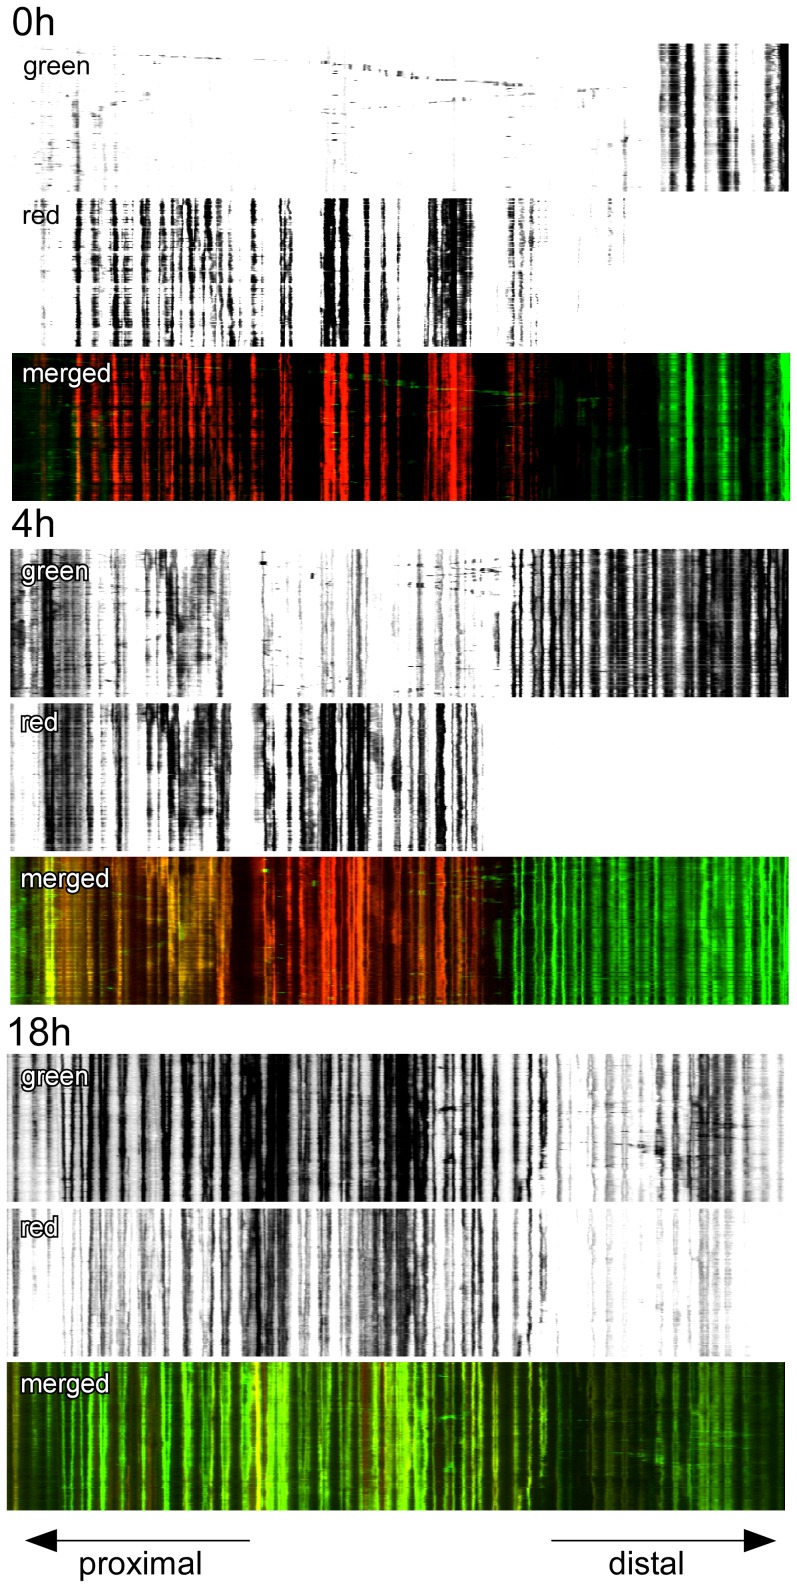
Inhibition of neuronal activity with TTX does not affect mitochondrial fusion in neurites.Kymographs show that fusion of mitochondria was unaffected by continuously blocking neuronal activity with TTX (1 µM final concentration). Time lapse images were taken every 10 seconds for 30 minutes at 0 h, 4 h, and 18 h following the marking of a subpopulation of mitochondria within a living neurite (27 div).